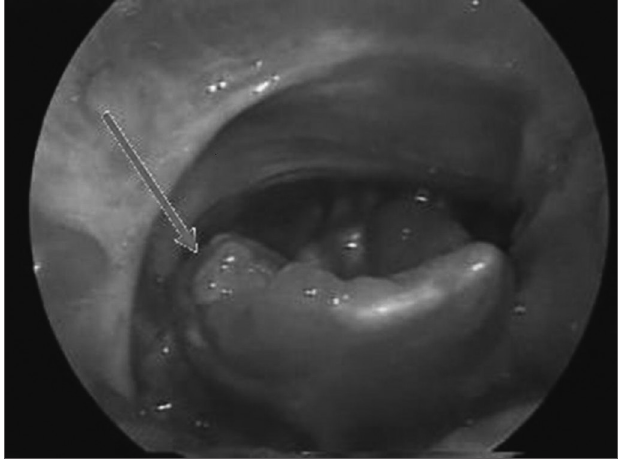
Figure 4. Atypical aphthous lesion in the lingual face of the right